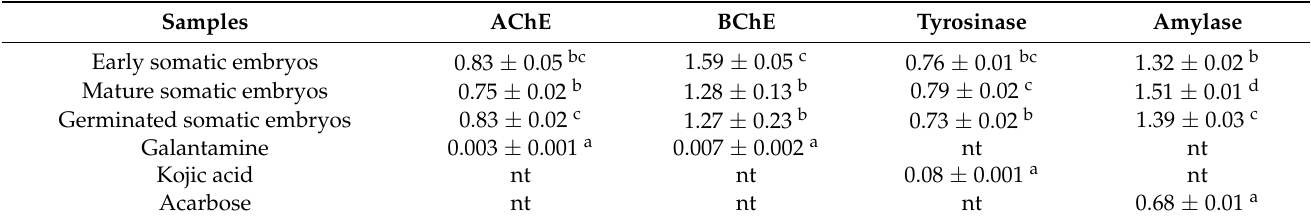
Table 6. Enzyme inhibitory effects of the tested samples (IC50 (mg